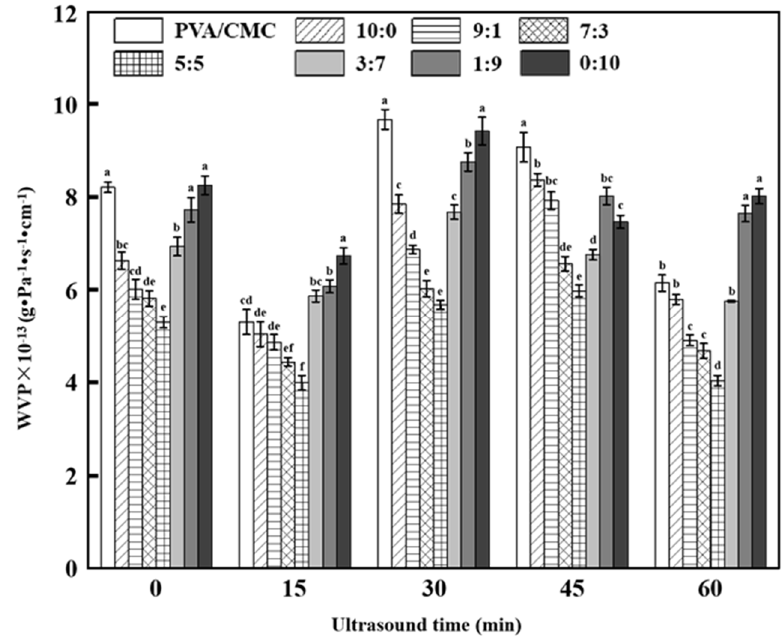
Figure 7. WVP (Determination of Water Vapor Permeability) of pure PVA/CMC and PVA/CMC/ZnO NPs/ x GnP composite films under different ultrasonication times. (* p < 0.05, n = 8).